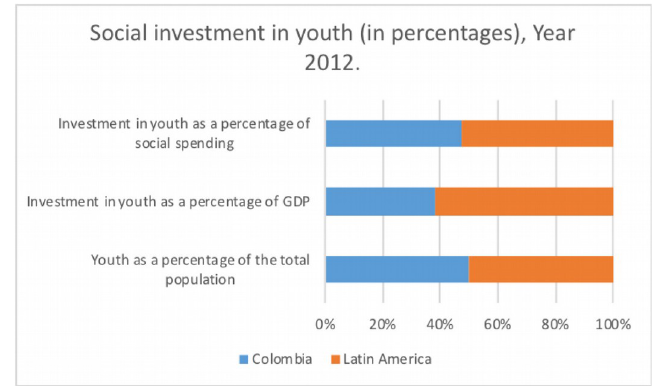
Figure 2. Social investment in youth (in percentages), Year 2012 (Economic Commission for Latin America and the Caribbean,